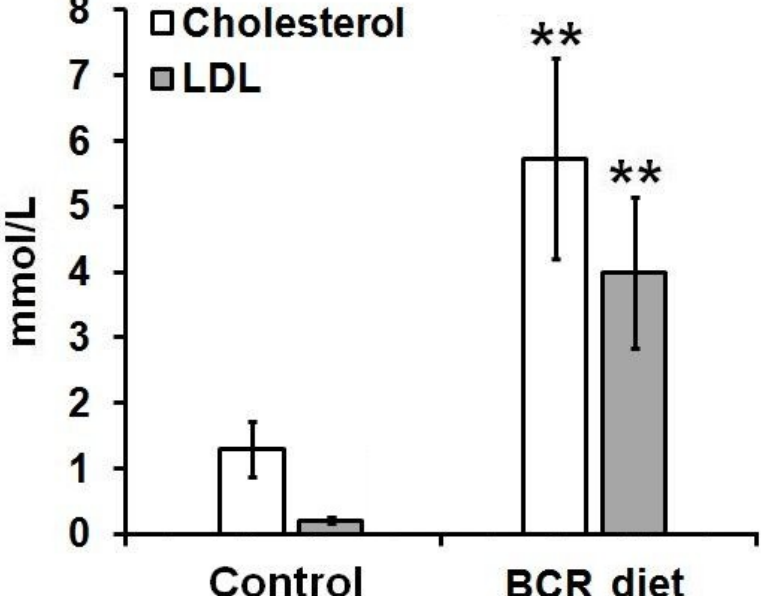
Figure 1. Effects of standard (Control) and BCR diets on serum lipid parameters (cholesterol and LDL) of the healthy control rats. Quantitative analysis of the serum cholesterol fractions after different feeding procedures. Significance level (compared to the control group): p ≤ 0.01 (**). BCR: butter and cholesterol rich; LDL: low-density